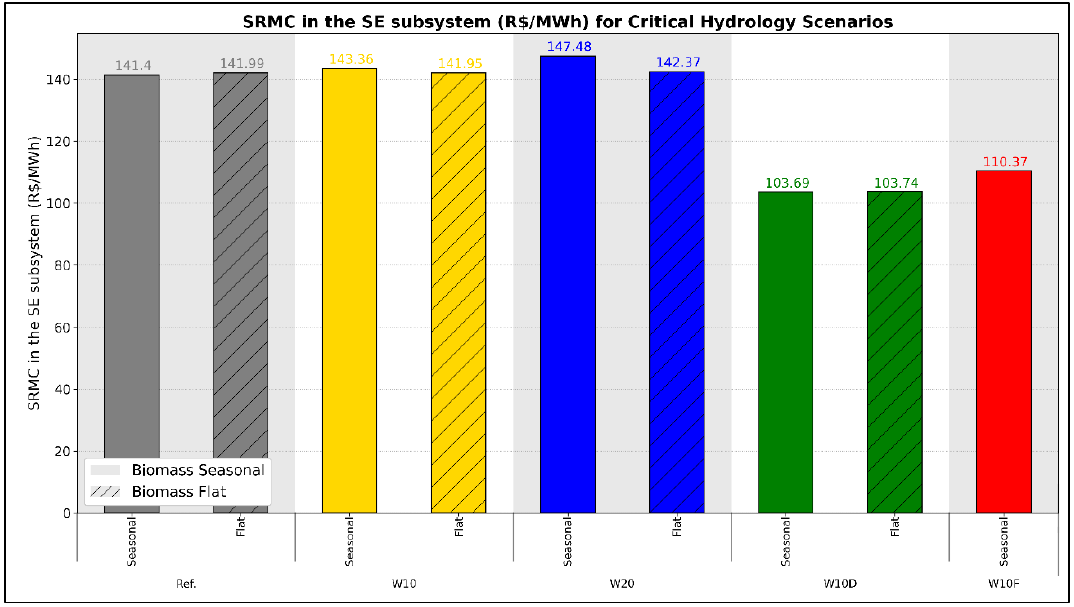
Figure 4. Short-run marginal cost for scenarios with critical hydrology.